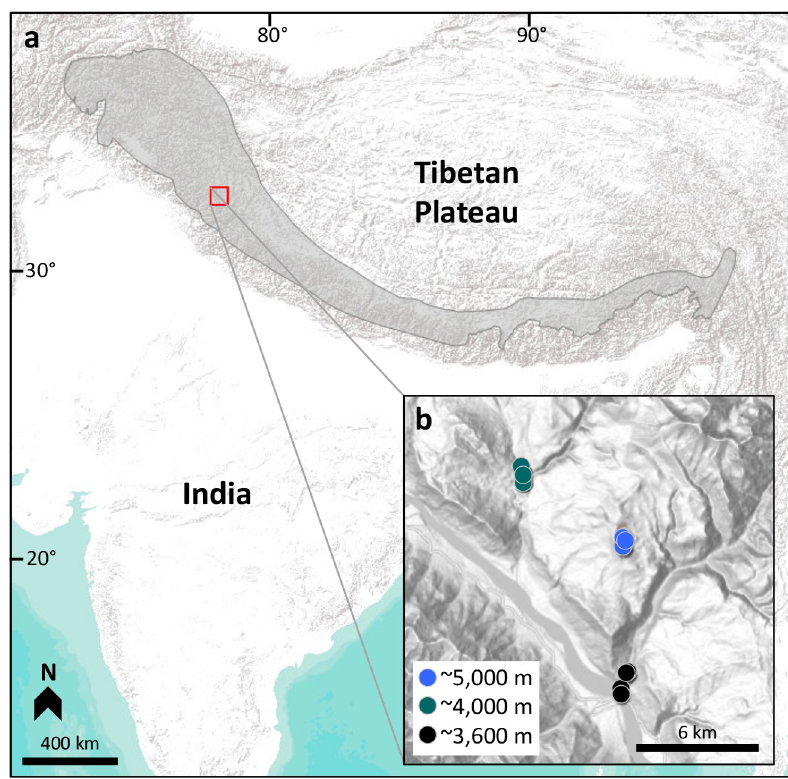
Fig 1. Sampling localities. (a) The complete IUCN distribution of O . roylei is shown in grey [32]. (b) The three sampling locations are indicated. Reprinted from ArcGIS under a CC BY license, with permission from Esri, original copyright